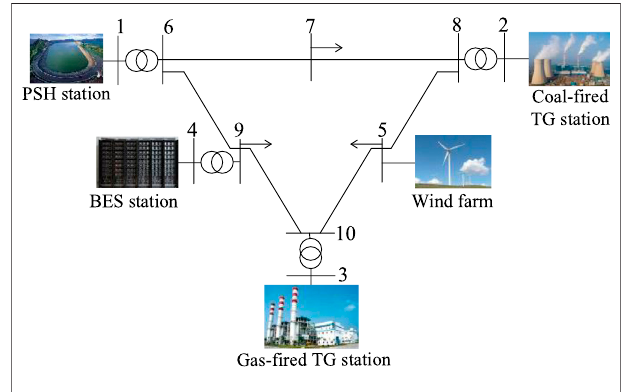
FIGURE 1 | Modi fi ed IEEE-9 bus system.